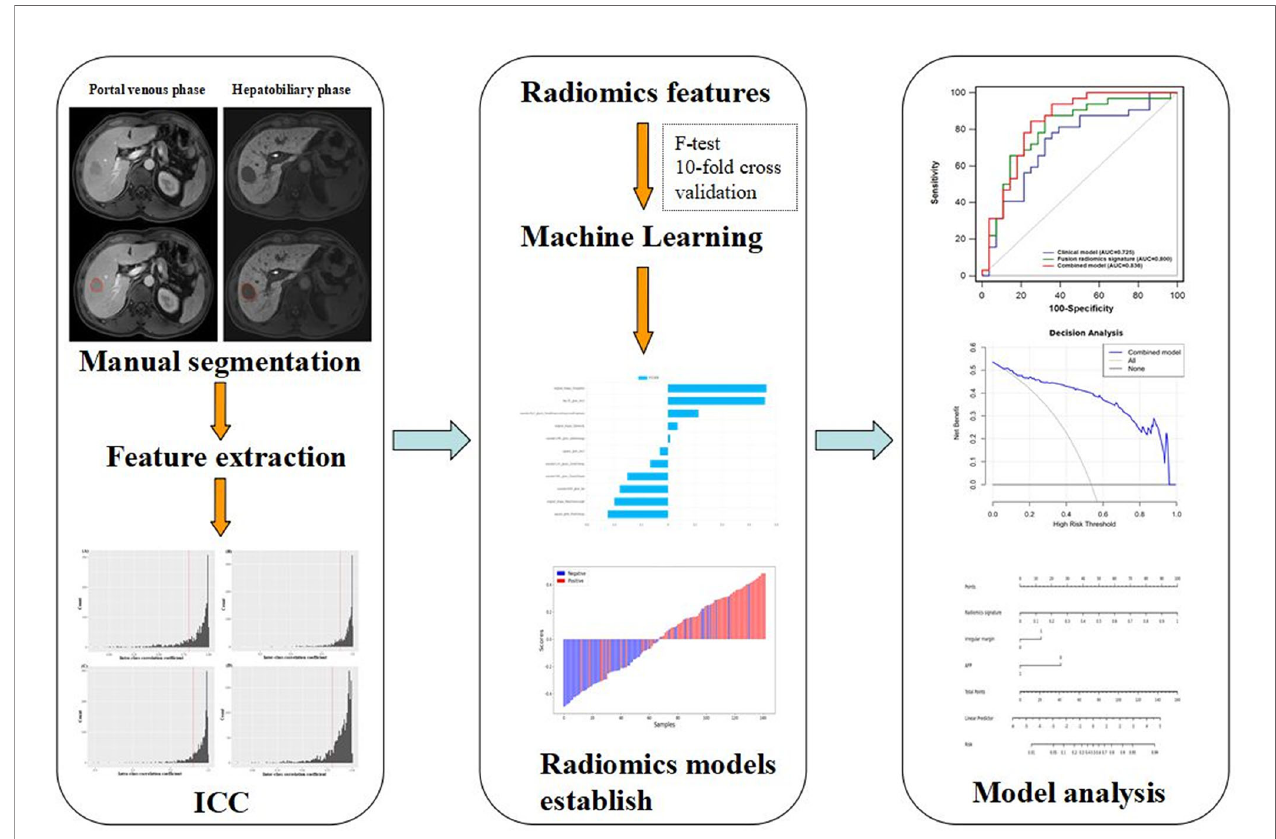
FIGURE 2 | Diagram of HCC lesions segmentation, feature extraction, ICC test, feature selection, and model establish and